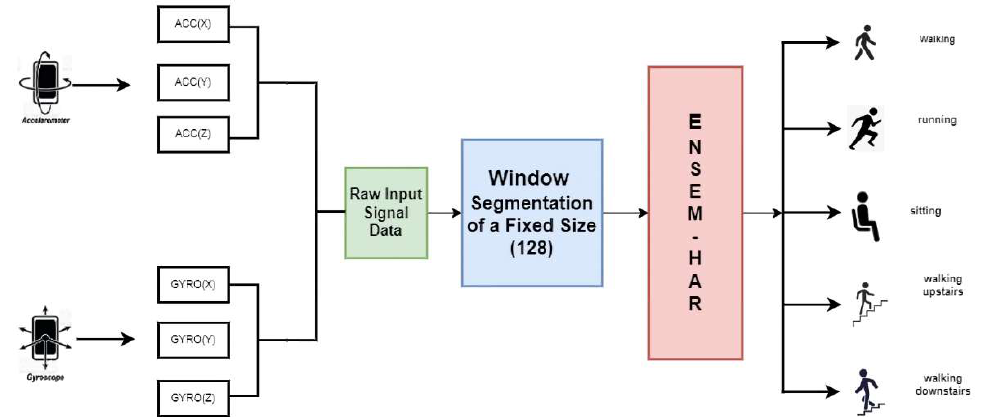
Figure 1. Illustrative overview of collecting the raw data from sensors, pre-processing and window segmentation on that raw data, and finally our proposed Ensem-HAR model for predicting human activities with that pre-processed data.